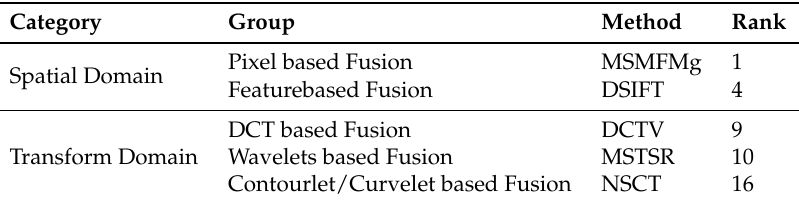
Table 10. The best performing MIF algorithm in each group.